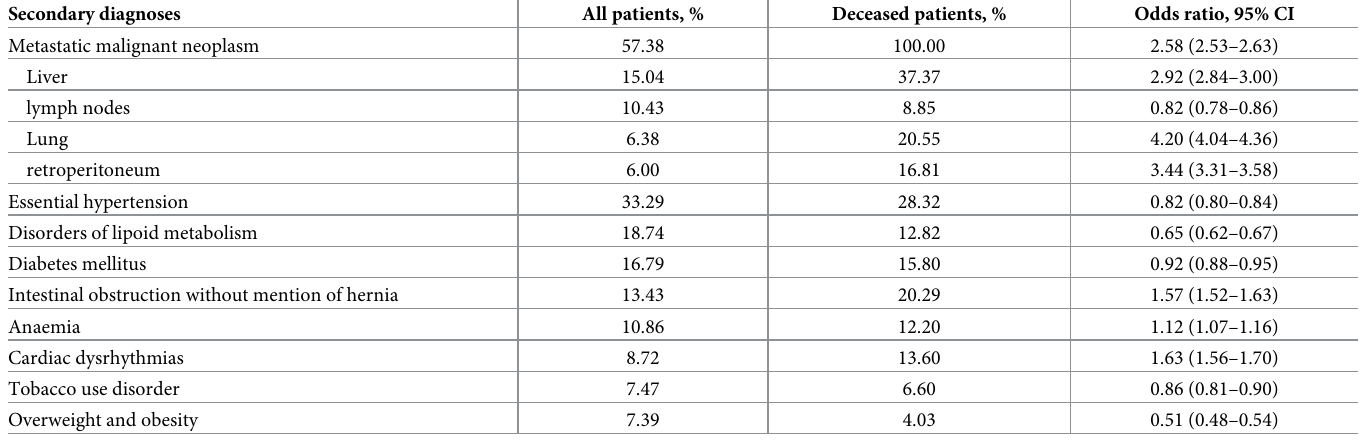
Table 4. Secondary diagnoses in patients with colorectal cancer and in deceased patients. Secondary diagnoses All patients,